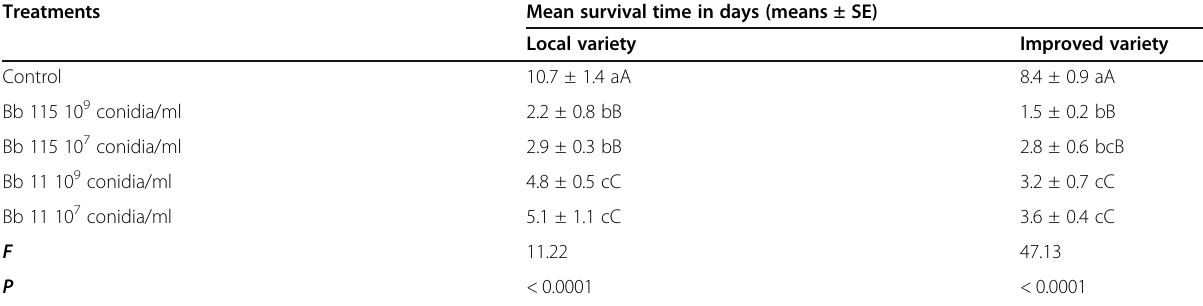
Table 1 Mean survival times (MSTs) in days of third-instar Helicoverpa armigera larvae fed using tomato leaves sampled from tomato inoculated and non-inoculated plants with seeds coasting at different Beauveria bassiana concentrations Treatments Mean survival time in days (means ±